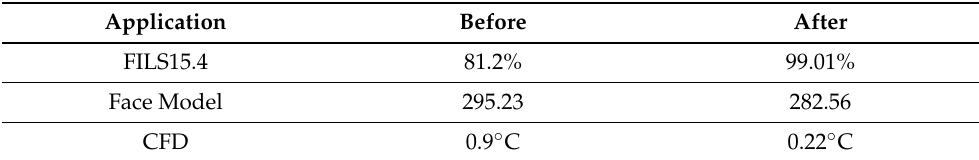
Table 14. Accuracy improvements in three applications.